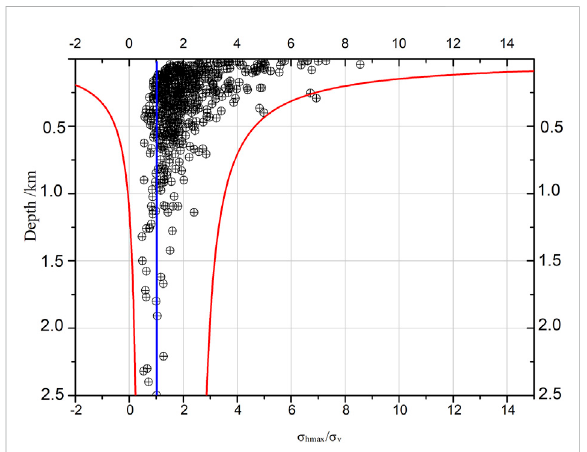
FIGURE 1 Distributionofmeasuredresultsandthetheoreticalratioof in situ stress. The black dot is the ratio of the maximum horizontal principal stress to the vertical stress when the cohesion is 30 MPa and the internal friction angle is 25 ° ; the theoretical ratio limit calculated by Eq. 3 is indicated by a red line in the fi gure.